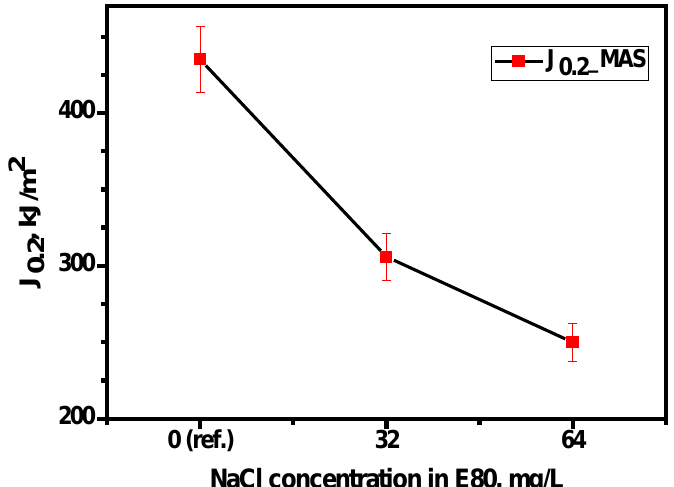
Figure 12. Variation of critical fracture toughness, J 0.2 with test environment.